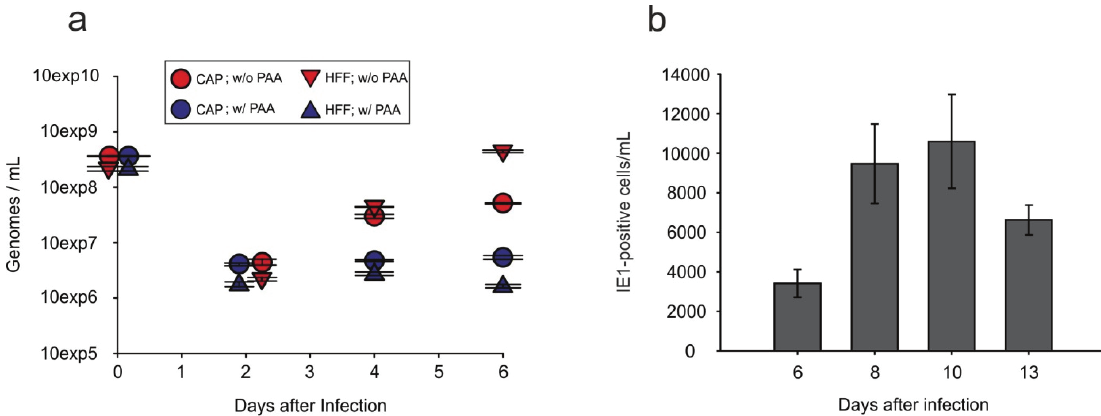
Figure 7. Viral genome release and release of infectious virus into the supernatant of infected CAP cells. ( a ) Quantitative PCR analysis of viral genome release from infected CAP adh. , measured by quantitative PCR. CAP adh. and control HFF were infected with TowneUL130rep at an m.o.i. of 2.5. At l.5 h after the addition of virus, cells were washed with 0.14 M NaCI, exposed to 0.l M glycine (pH 3.0) for 1 min to inactivate residual virus, and were subsequently washed with maintenance medium. Afterwards, cells were either incubated with or without the addition of 0.25 mg/mL PAA. Cells were collected at two days, four days and six days after infection. Viral DNA was extracted and analyzed by real-time PCR. Results were calculated in genome copies per cell. Error bars represent means of three technical replicates; ( b ) Analysis of the release of infectious virus by CAP adh. through IE1-staining. Cells were infected with TB40/E-UL16EGFP at an m.o.i. of 10. Supernatants were collected and tested in serial dilutions in eight biological replicates on HFF for the number of IE1-positive cells. Error bars represent means of eight technical replicates.